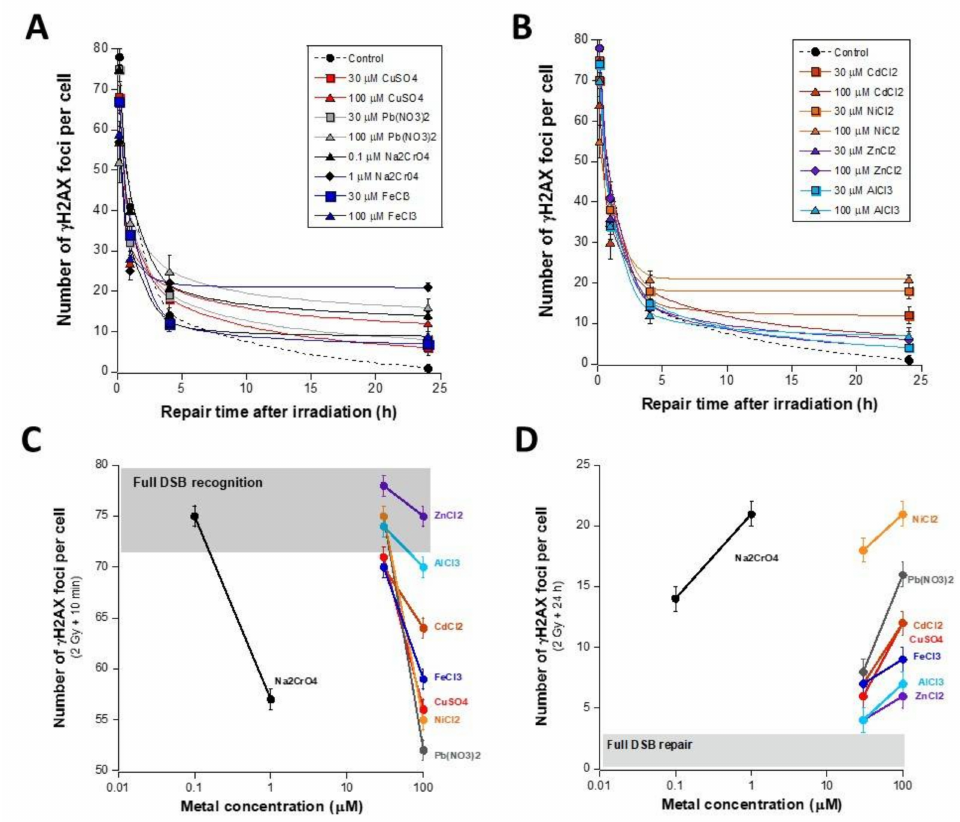
Figure 3. RI DSB repair kinetics after metal exposure. ( A , B ) The number of γ H2AX foci as a function of repair time post-irradiation in the human untransformed radioresistant 149BR incubated for 24 h with the indicated concentration of metal species. Each plot represents the mean ± standard error (SEM) of at least three replicates. ( C ) The γ H2AX data shown in panels ( A , B ) and obtained after 10 min post-irradiation were plotted against the metal concentration. The grey zone corresponds to the numerical values when all the RI DSB are recognized. A decrease in the number of γ H2AX foci is interpreted as a defect in the DSB recognition. ( D ) The γ H2AX data shown in panels A and B and obtained after 24 h post-irradiation were plotted against the metal concentration. The grey zone corresponds to the numerical values when all the RI DSB are unrepaired. An increase in the number of γ H2AX foci is interpreted as a defect in the DSB